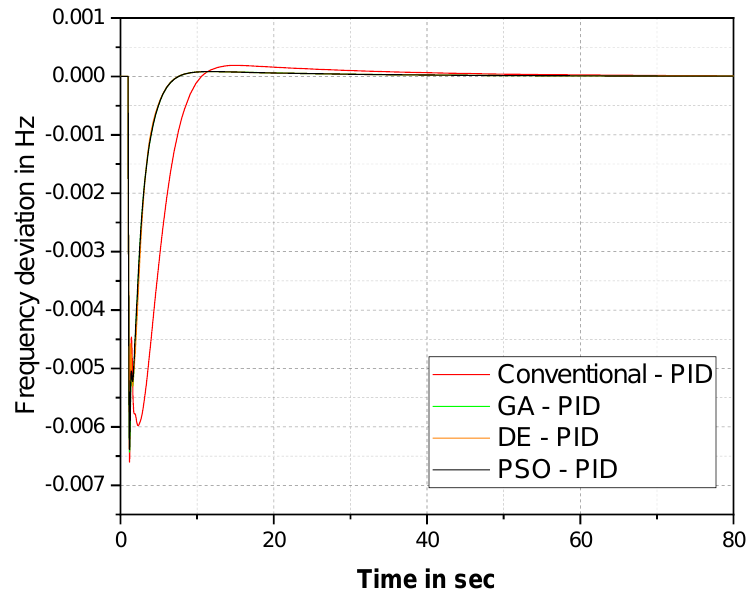
Figure 7. delF comparison for the ISE cost function. Table 4. Controlled parameters of delF using the ISE cost function.